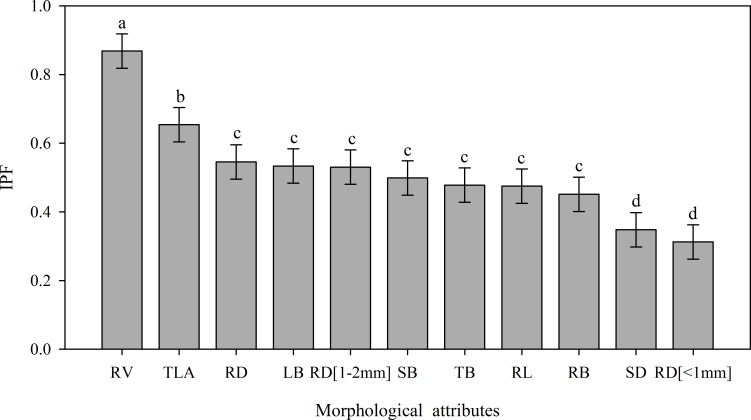
Phenotypic plasticity index (IPF) for growth characters of cacao progenies, obtained from complete diallel crosses, under control (predawn ΨWL between -0.1 and -0.5 MPa) and drought (predawn ΨWL between –2.0 to –2.5 MPa) conditions.SD = stem diameter (mm); TLA x 10−4 = total leaf area per plant (m2 plant-1); RB = root biomass (g); SB = stem dry biomass (g); LB = leaf dry biomass (g); TB = total dry biomass (g); RL = root length (mm); RD = root mean diameter for second order branches (mm); RV = root volume (cm3); RD[<1 mm] = fine roots length (cm cm-3); RD[1-2mm] = medium roots length (cm cm-3).